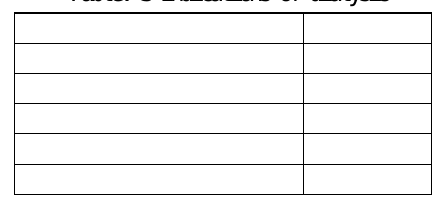
The majority (70%) of ARF patients recovered, whereas all patients of acute on CRF had improved after, on an average, five sessions of HD. Most of the patients (n=14) of ESRD dropped out after initial session of HD (Table: 4). Among the drop outs most of the patients ((52%)) had undergone maximum of five sessions of dialvsis. Table: 4 Outcome of patients on HD